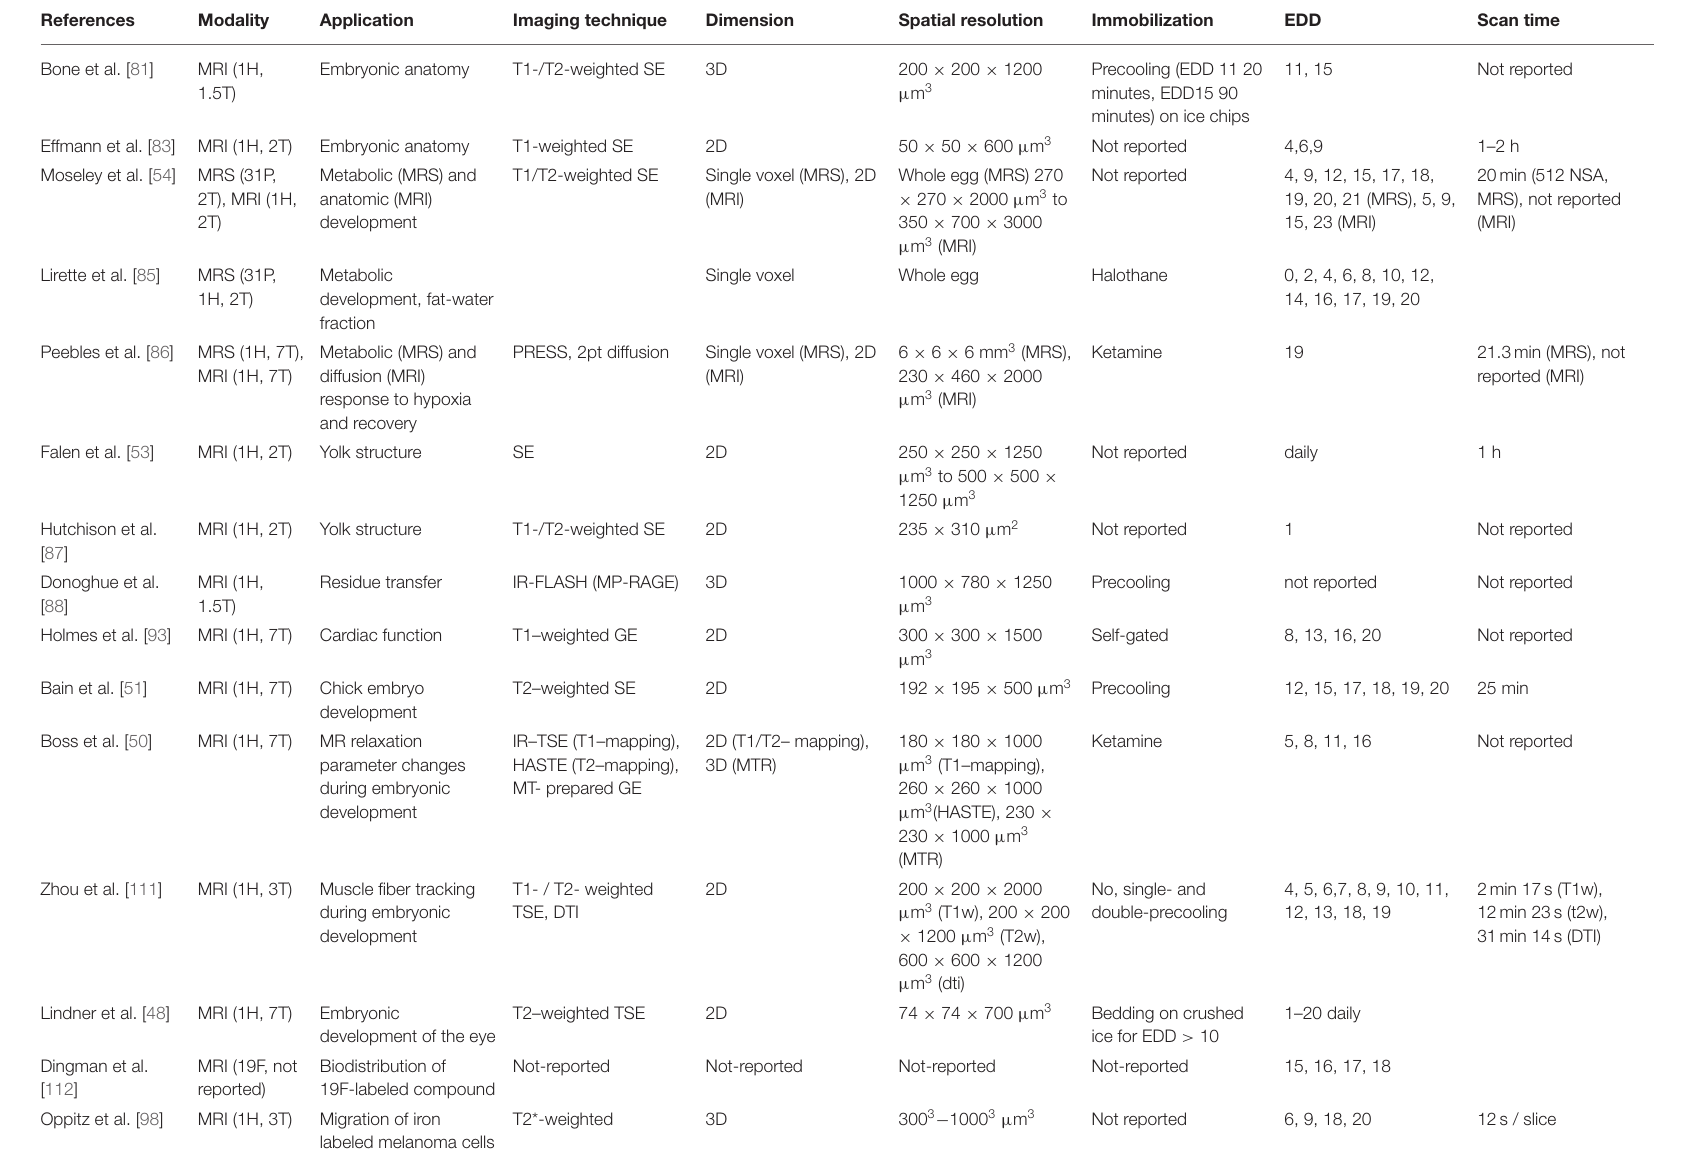
TABLE 1 | Overview of reported in vivo in ovo imaging and spectroscopy